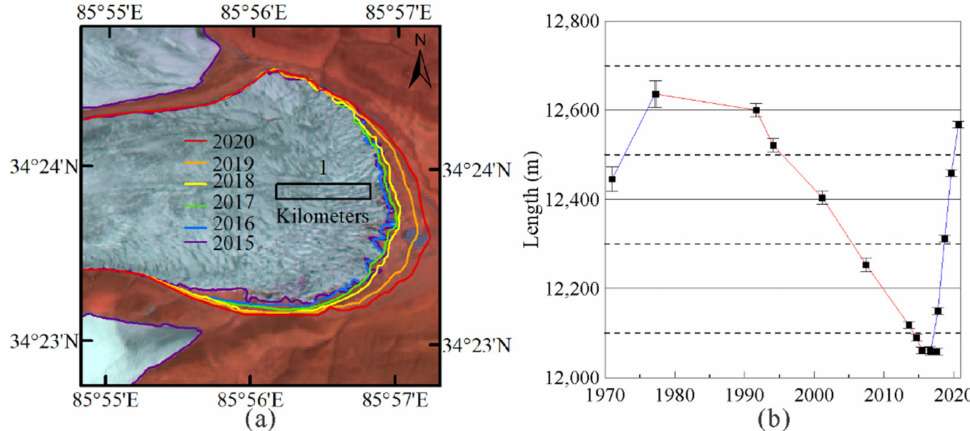
Figure 4. ( a ) Snout advance after 2016; ( b ) the length change of the surging